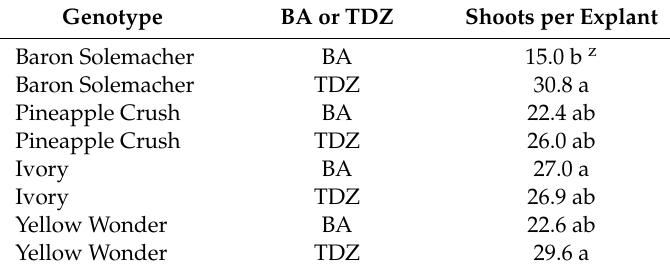
Table 2. E ff ect of genotype and BA at 2.0 mg L − 1 plus IBA at 0.25 mg L − 1 , or TDZ at 1.5 mg L − 1 plus IBA at 0.25 mg L − 1 , on shoot regeneration from shoot explants of Fragaria vesca. Data were collected after 9 weeks of